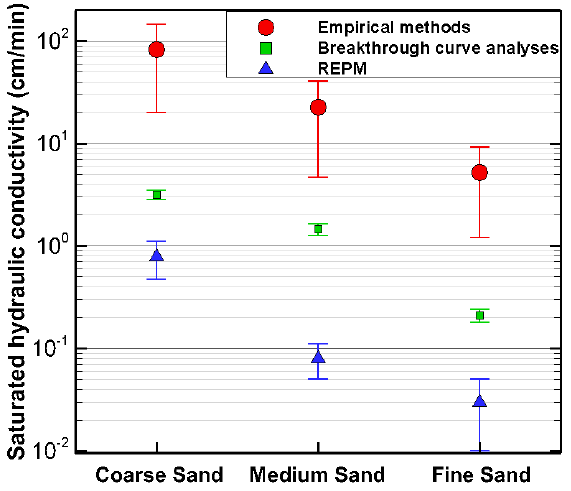
Figure 7. Comparison of the estimated saturated hydraulic conductivities among the empirical methods, the REPM and analytical solution and breakthrough curve analyses. Symbols and Bars represent means and standard deviations, respectively.